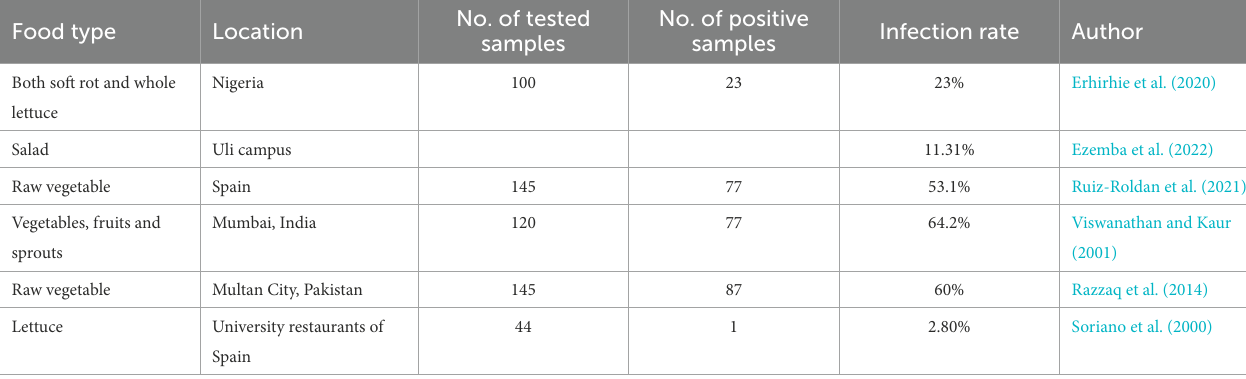
TABLE 3 Prevalence of P. aeruginosa in different types of